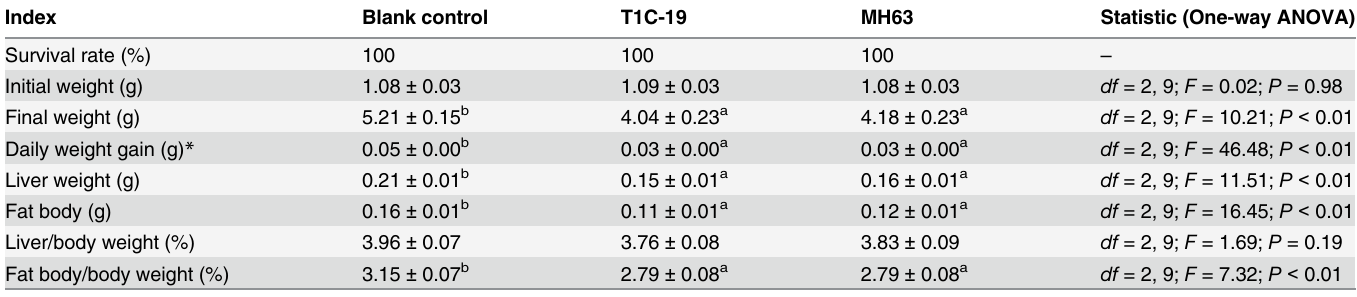
Table 5. Survival and organ weight of Xenopus laevis froglets fed diets containing transgenic cry1Ca rice (T1C-19) grains and non-transformed isoline (MH63) grains for 90 days (n = 4).